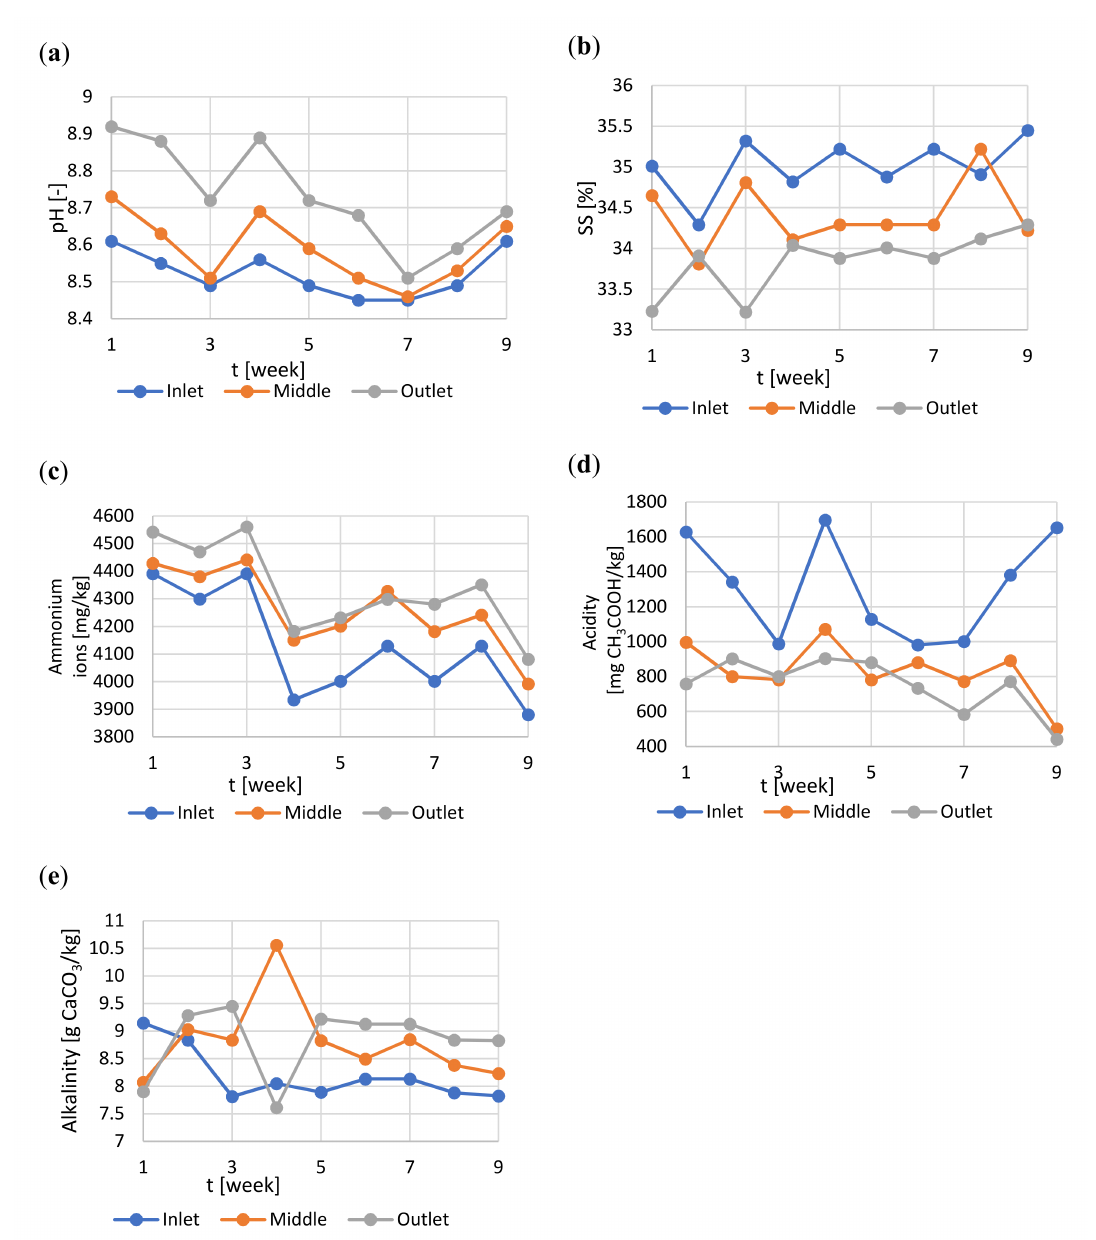
Figure 3. Changes of the parameters during the anaerobic digestion process in full scale: ( a ) pH value; ( b ) suspended solids; ( c ) ammonium ions concentration; ( d ) acidity; ( e )